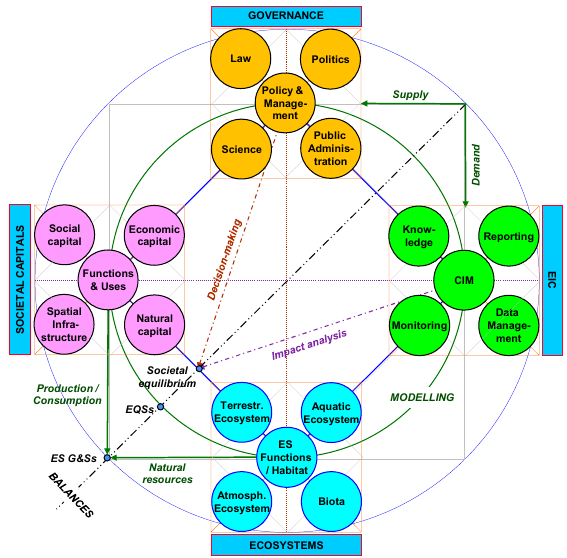
Figure 5. Superposition of the PT Model and GASI. Integration of GASI allows simplification of the PT Model framework, as only two key interactions are added: impact analysis and decision-making. Additional features such as modelling and balances are added, allowing the linkage of fundamental topics related to sustainable development. (See text for further description and